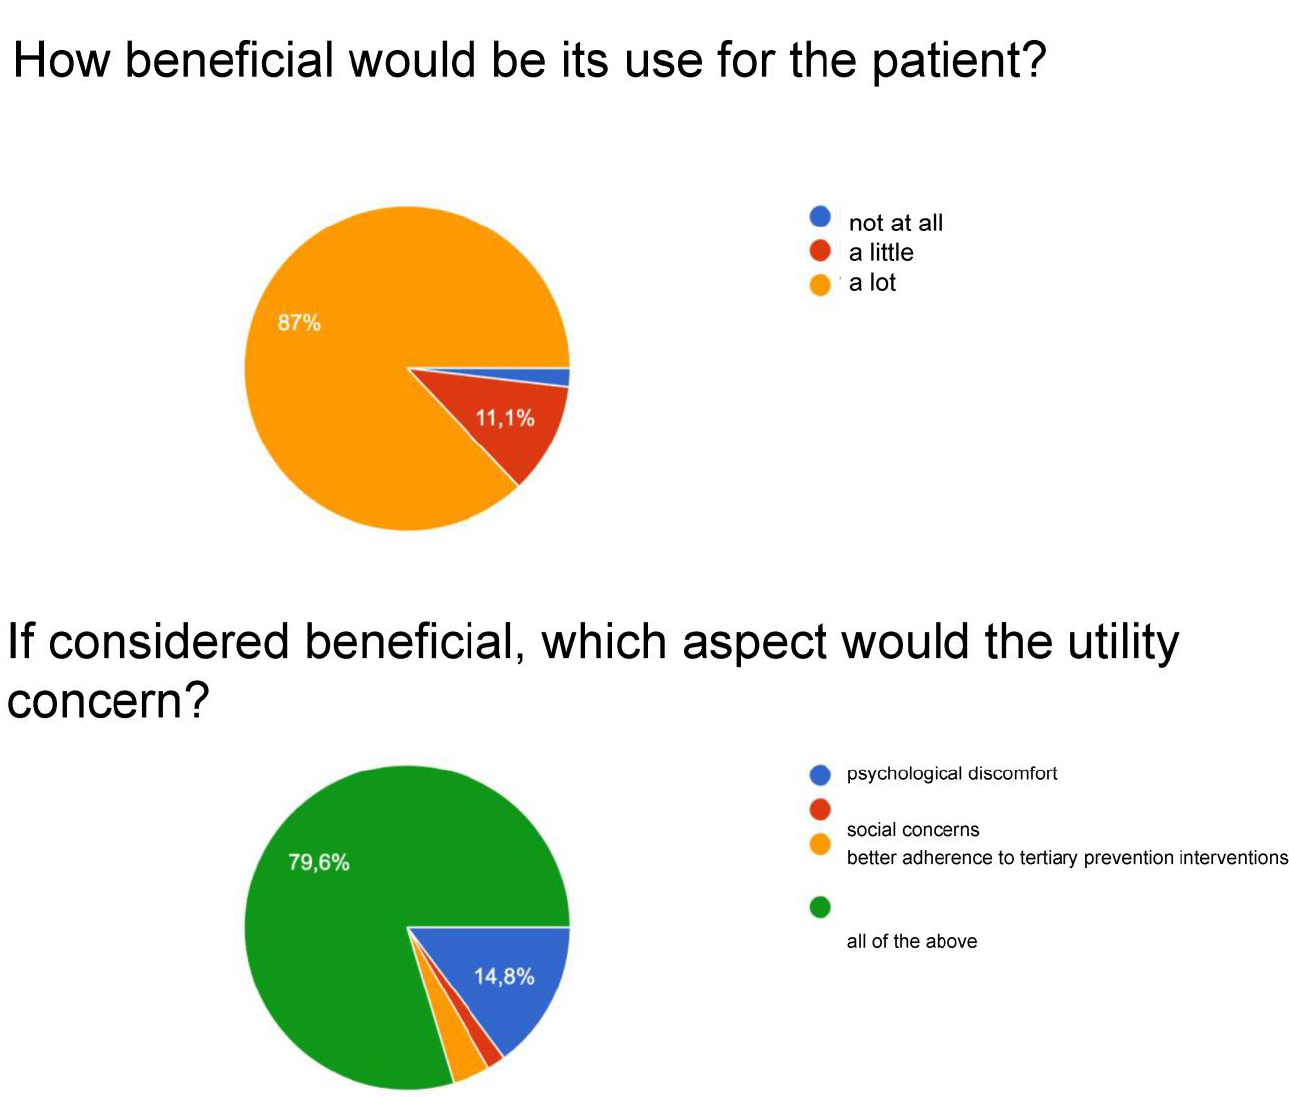
Figure 3. Oncologists. Figure 3.